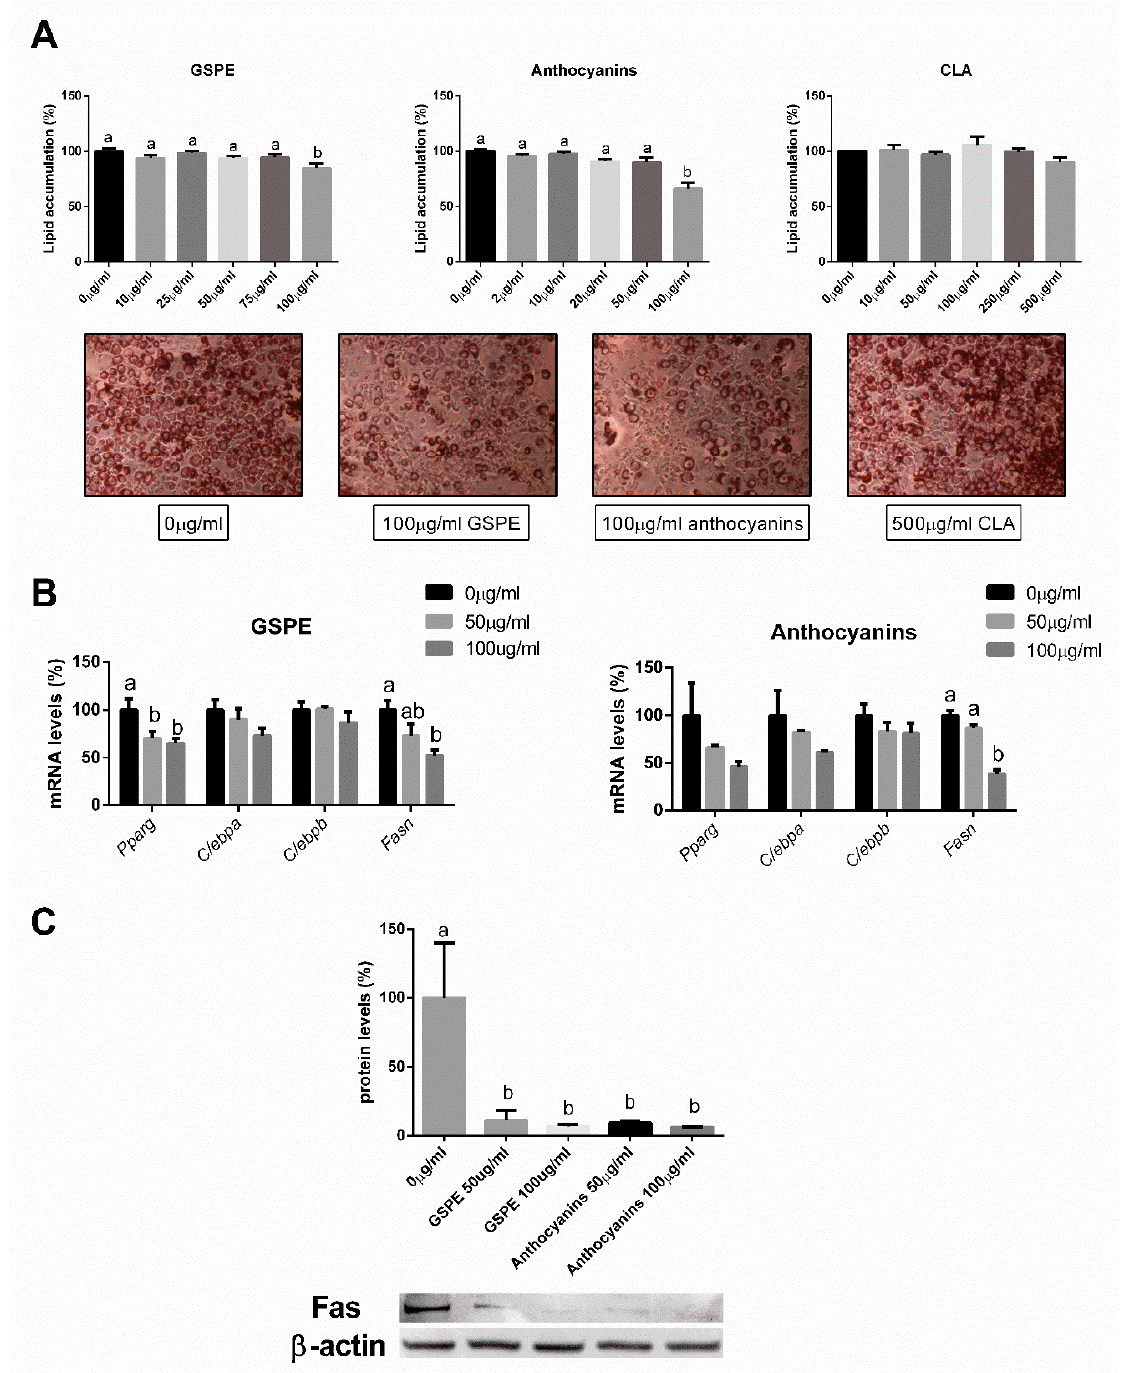
Figure 5. Effects of GSPE, anthocyanins, and CLA on lipid accumulation measured with Oil Red O ( A ), effects of GSPE and anthocyanins on mRNA levels of adipogenesis and lipogenesis genes ( B ), and protein levels of Fasn measured with Western blot of differentiated 3T3-L1 cells treated with various concentrations during the differentiation phase ( C ). The data are expressed as the mean ± SEM ( n = 16) of three independent experiments, and differences among groups are measured with one-way ANOVA followed by Duncan’s post hoc test. Mean values with unlike letters have significant difference among groups.